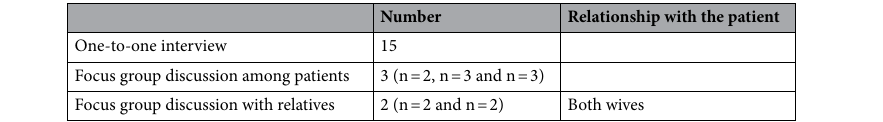
Table 2. The groups of